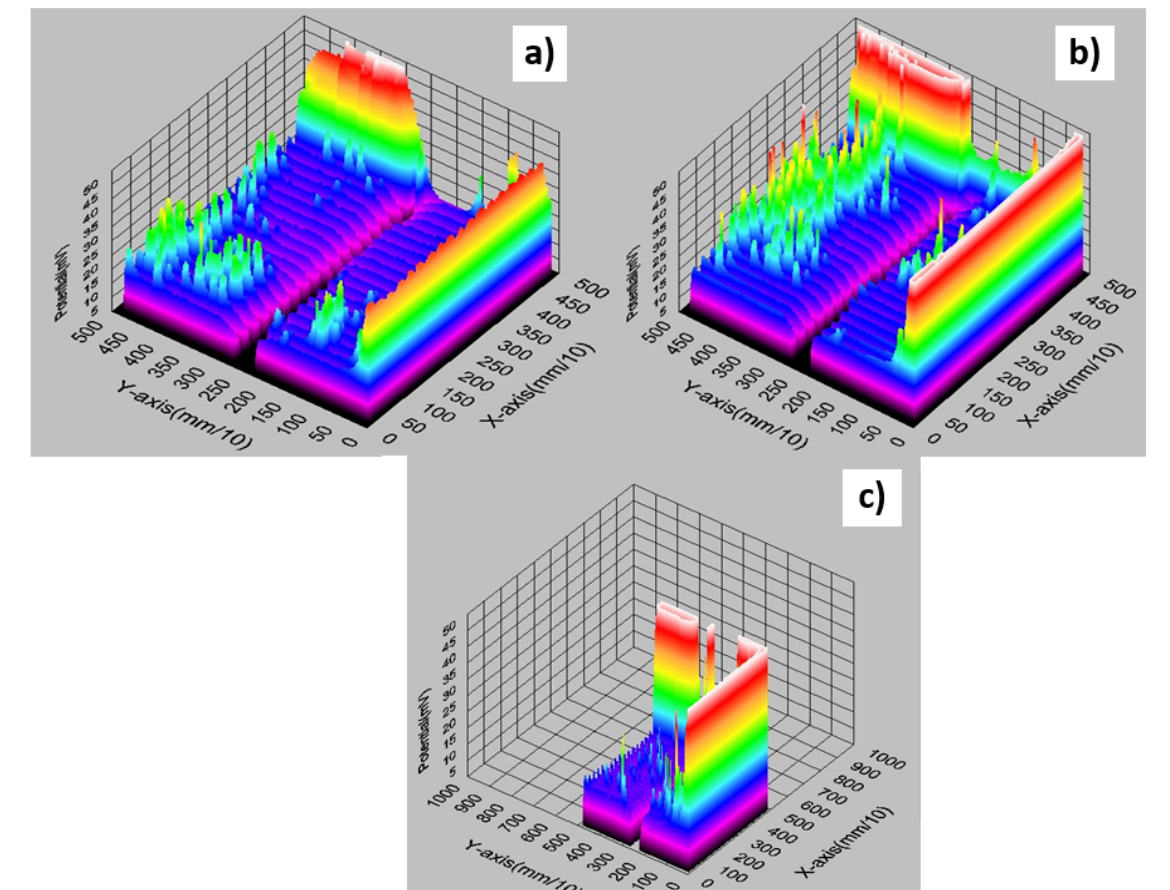
Figure 7. An example of the graphical distribution of the resistance of photovoltaic cells with front metallisation fired in an infrared IR furnace at different temperatures: ( a ) 900 °C, ( b ) 910 °C, ( c ) 920 °C (original 3D print from the Corescan device software).